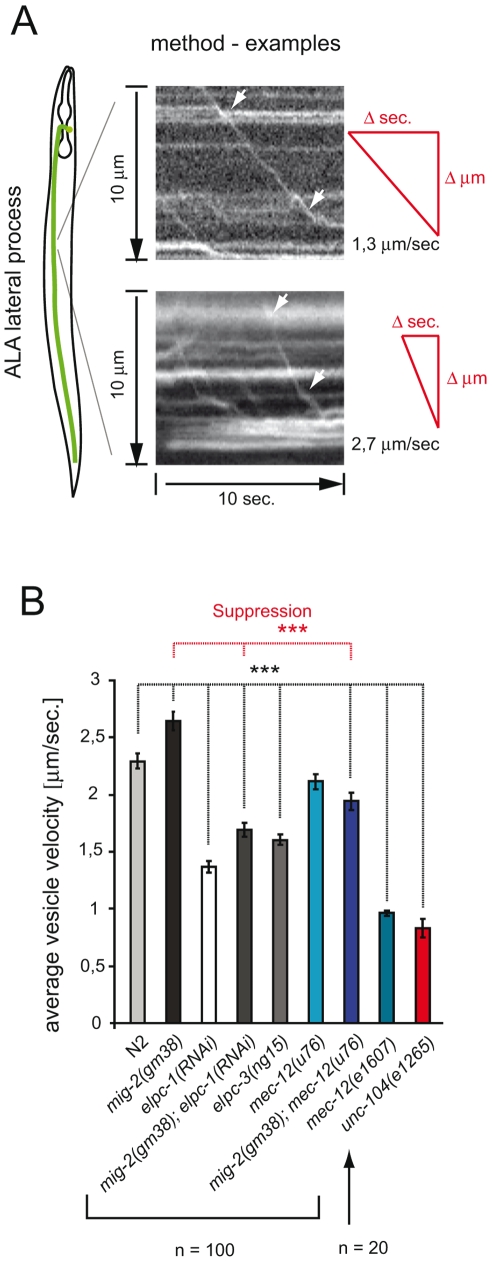
Velocity of Dense Core Vesicles is regulated by acetylation of α-tubulin.(A) Scheme depicting how kymographs of vesicles marked by IDA-1::GFP were obtained from ALA neurons of adult animals to measure the velocity. One slow vesicle (1,3 µm/sec) and one faster vesicle (2,7 µm/sec) are shown as examples. (B) Graph summarizing mean velocities in different genetic backgrounds. Mean velocities reflect the degree of acetylation of α-tubulin. mig-2(gm38) is faster, elongator mutants/RNAi are slower. mec-12(u76) can modulate the mig-2(gm38) velocity phenotype. Likewise elpc-1(RNAi), mec-12(e1607) and unc-104(e1265) [example for slow vesicles [43]]. P values: ***<0,001. Error bars: SEM.